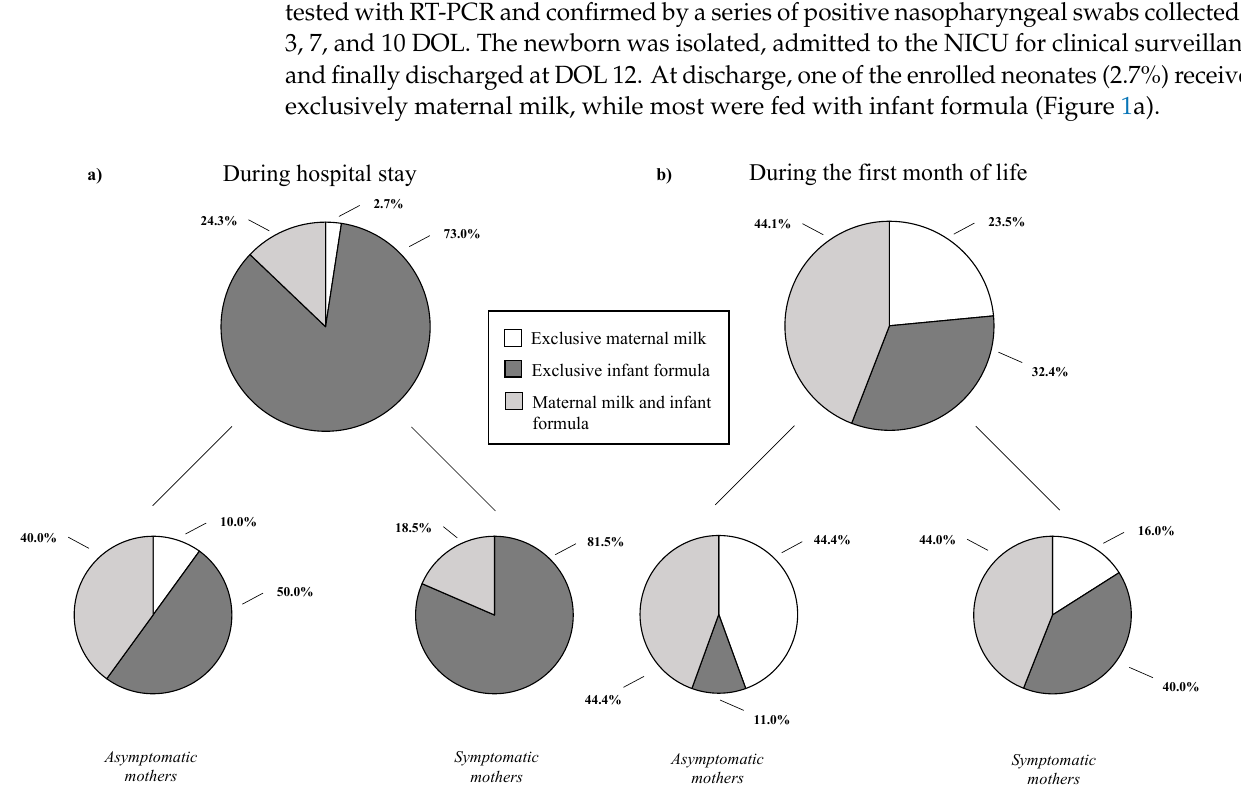
Figure 1. Feeding methods of the neonates enrolled in the study. As shown in the figure, ( a ) is “during hospital stay” and ( b ) is during the first month of life.